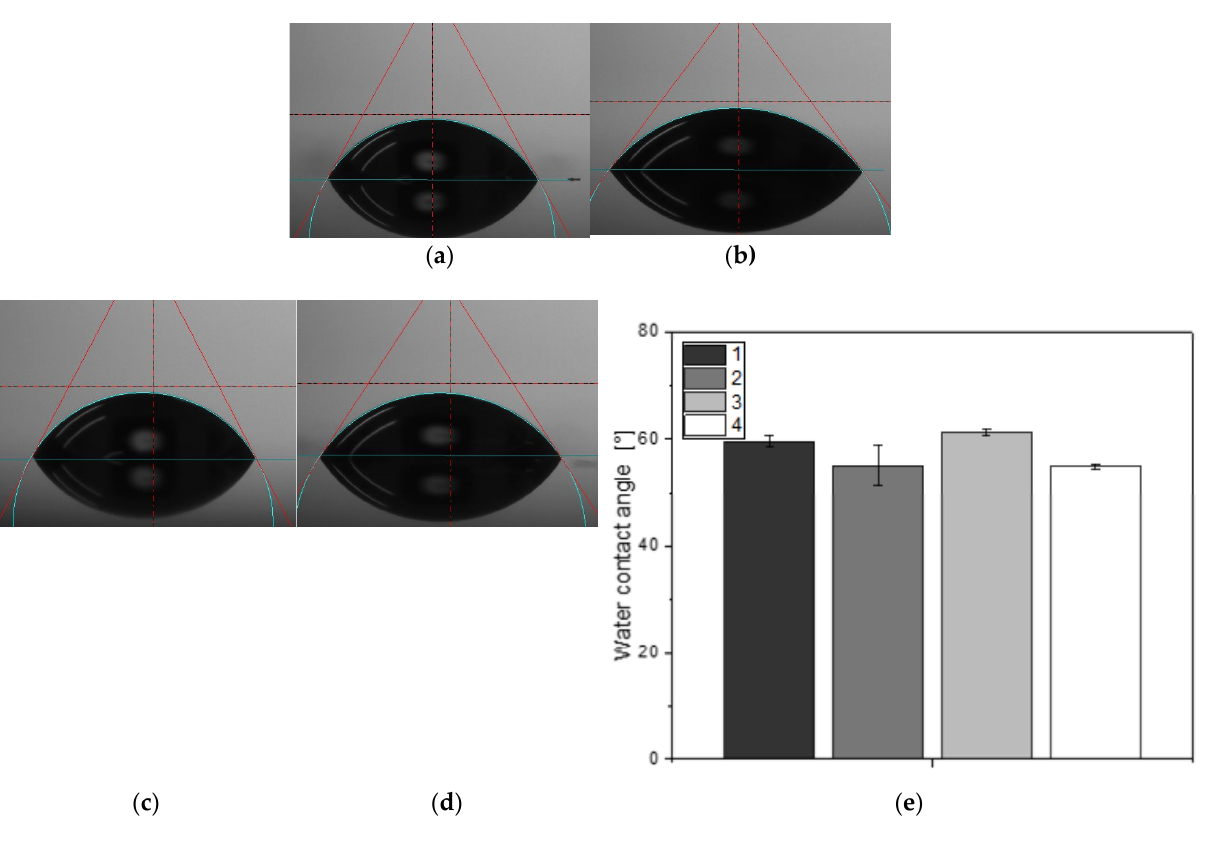
Figure 4. Contact angle measurements. Images of a water droplet on the surfaces on ( a ) coating 1 (according to Table 1), ( b ) coating 2 (according to Table 1), ( c ) coating 3 (according to Table 1), ( d ) coating 4 (according to Table 1), ( e ) Contact angle of the tested coatings.